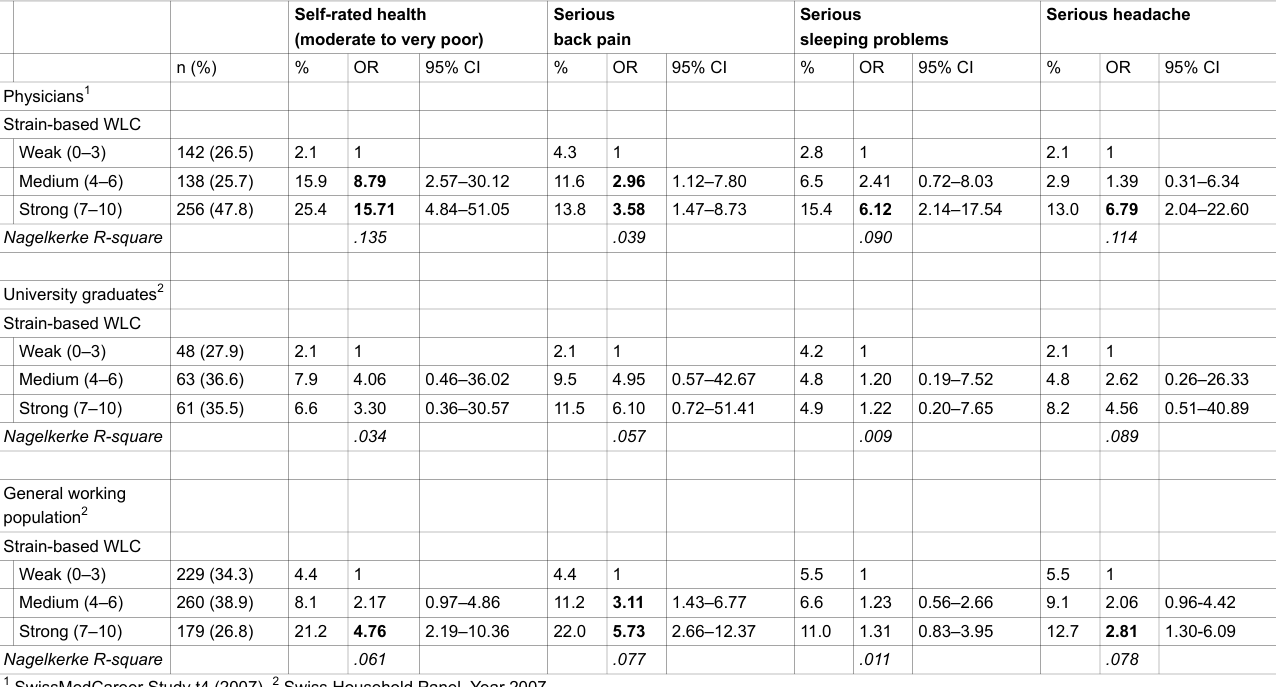
Table 4 Logistic regression from strain-based work-life conflicts for different health outcomes – controlled for gender (not controlled for age because of the small age range of all samples); significant Odds ratios (OR) bold ( p ≤